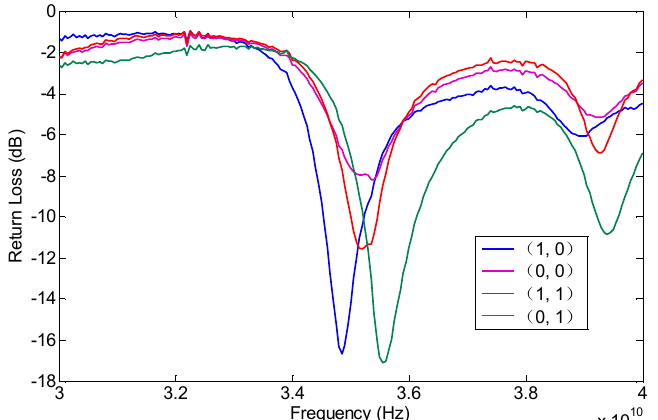
Figure 7. The measured return loss of the proposed pattern reconfigurable antenna in all states of the RF MEMS switches.